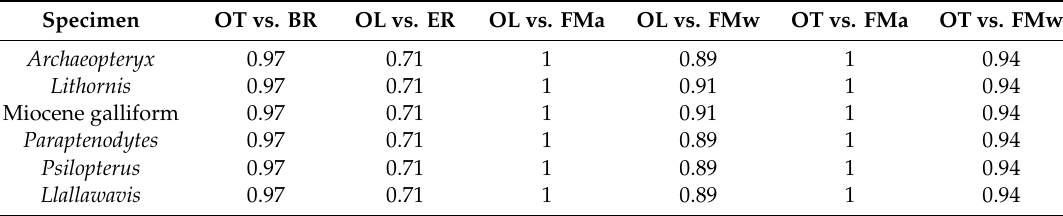
Table 7. Resulting p -values of the phylogenetic ANCOVA comparing the intercept of each extinct member of the sample to the intercept of the rest of the sample, given a common slope, with the outliers Apteryx and Dinornis excluded. These p -values have been adjusted with the Benjamini and Hochberg [89] procedure to control for false discovery rate; unadjusted p -values are available in Table S3. Abbreviations: BR, brain-remainder volume (brain volume minus optic-tectum volume); ER, endocast-remainder FMw, foramen-magnum width; OL, optic-lobe surface area; OT, optic-tectum